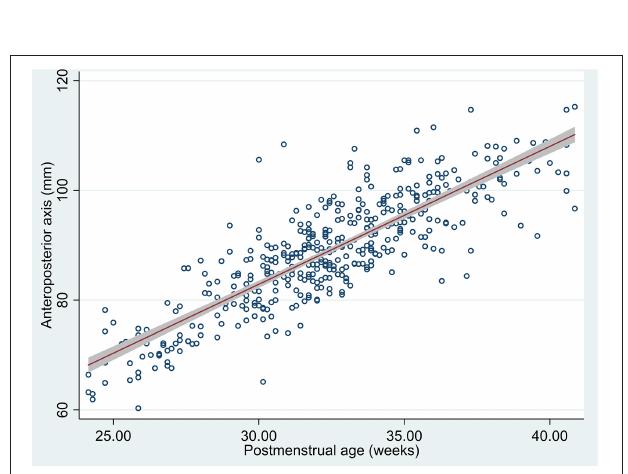
FIGURE 5 | Scatterplot of anteroposterior axis by post-menstrual age measured in US, predicted mean and 95% confidence interval of the population